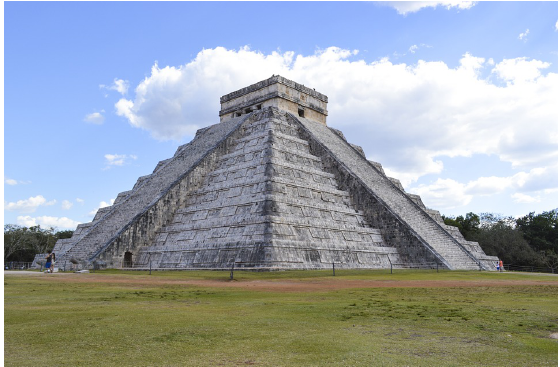
Figure 3. The Chichén Itzá pyramid in Tinum, Mexico. Photo license: Creative Commons